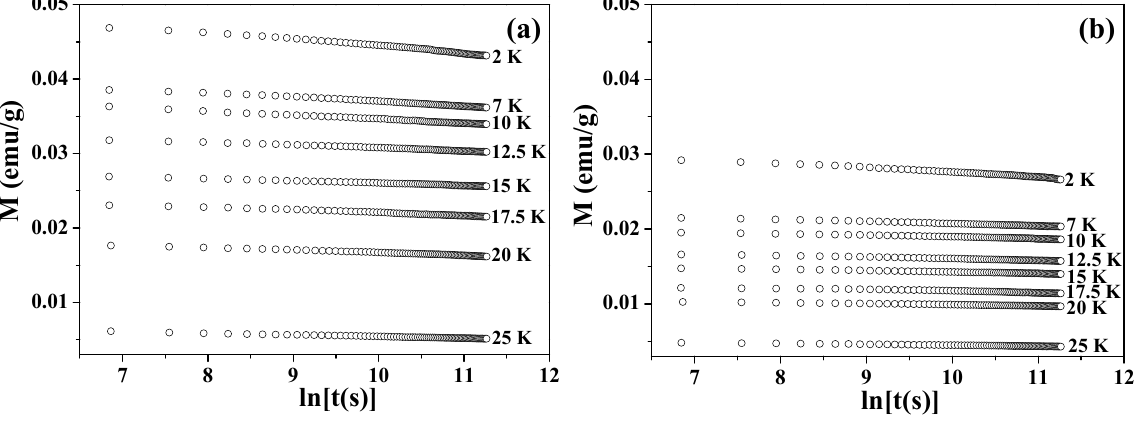
O hollow spheres 3 4